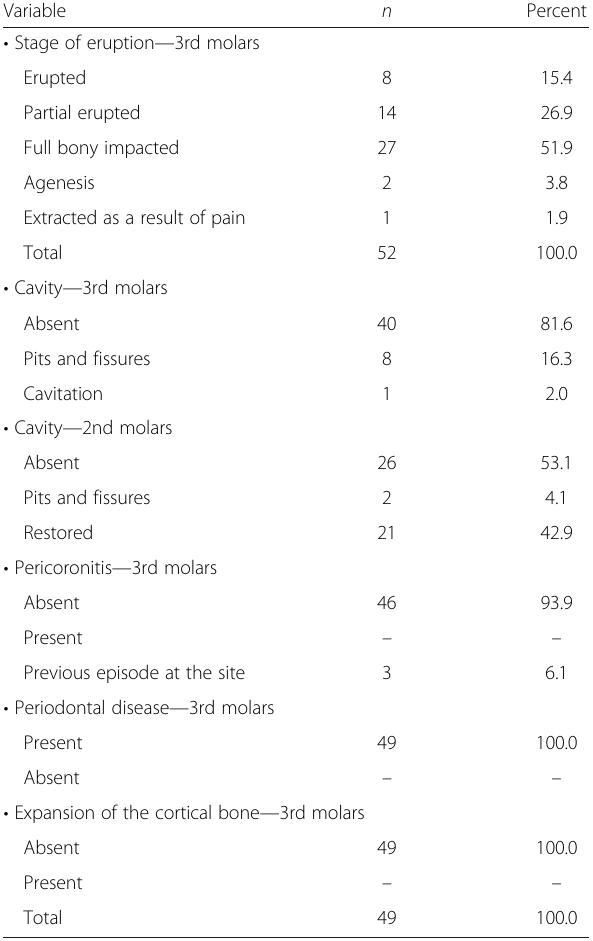
Table 1 Classification and prevalence of dental diseases analyzed according to the clinical data (T1) Variable